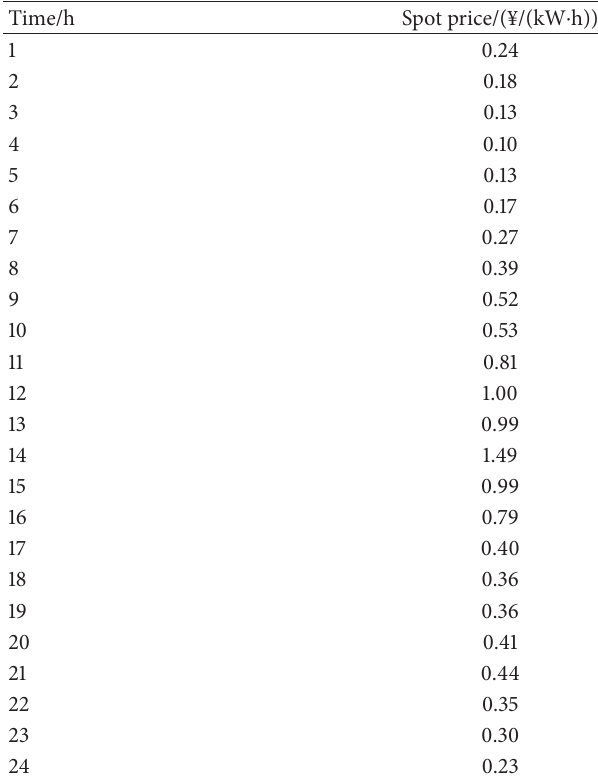
Table 3: Emission characteristics of both traditional power plant and distributed generation (g/kW ⋅ h).